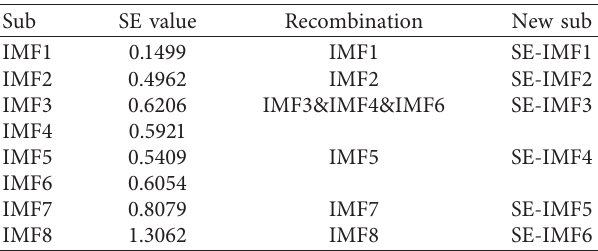
Table 3: Recombined by the SE value of VMD subsequence of data set A.